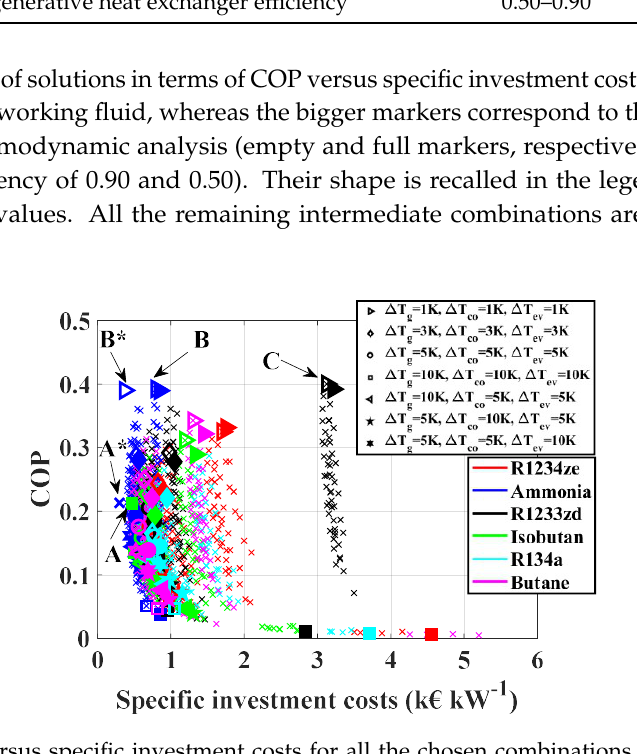
Figure 6. COP versus specific investment costs for all the chosen combinations. The highlighted markers refer to the solutions investigated for the thermodynamic analysis and each color is related to a specific working fluid. Table 6. Summary of the three configurations chosen as possible optimum case. The asterisk solutions refer to the use of a plate heat exchanger instead of a shell and tube heat exchanger for the low- pressure evaporator.